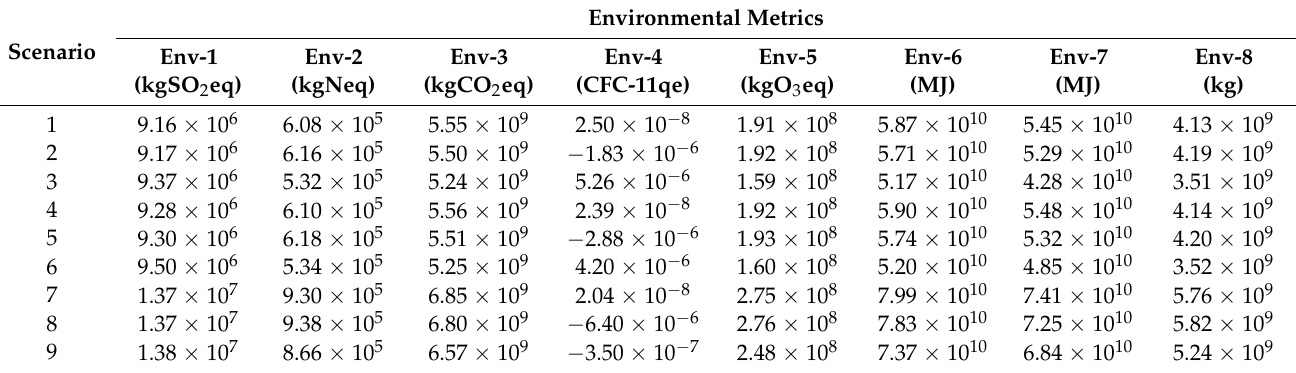
Table 7. Environmental impact analysis results for all stages, A1 to C4.